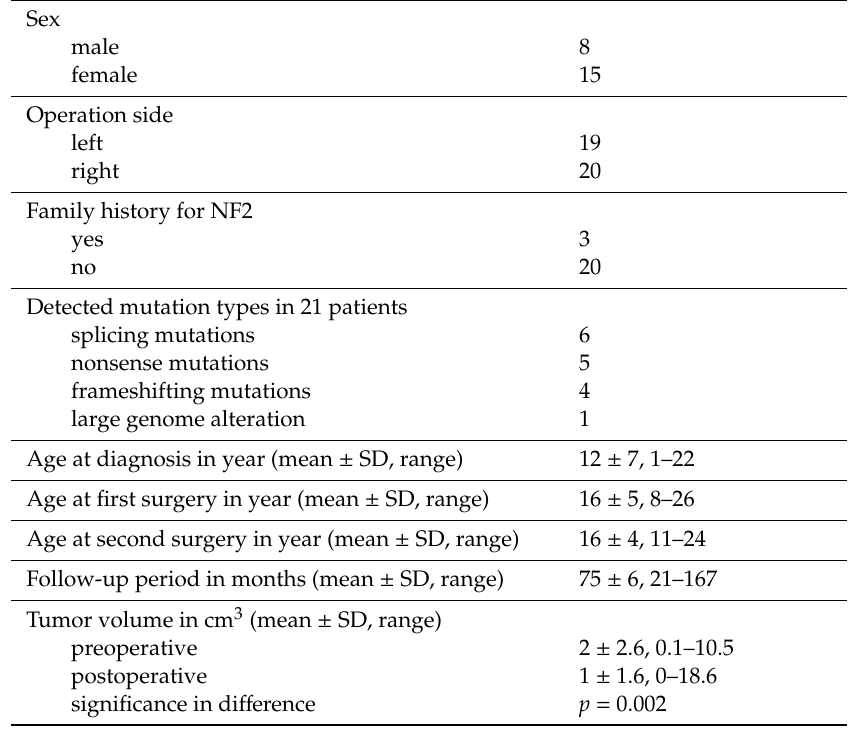
Table 1. Demographic data of 23 young, operated-on neurofibromatosis type 2 (NF2) patients (39